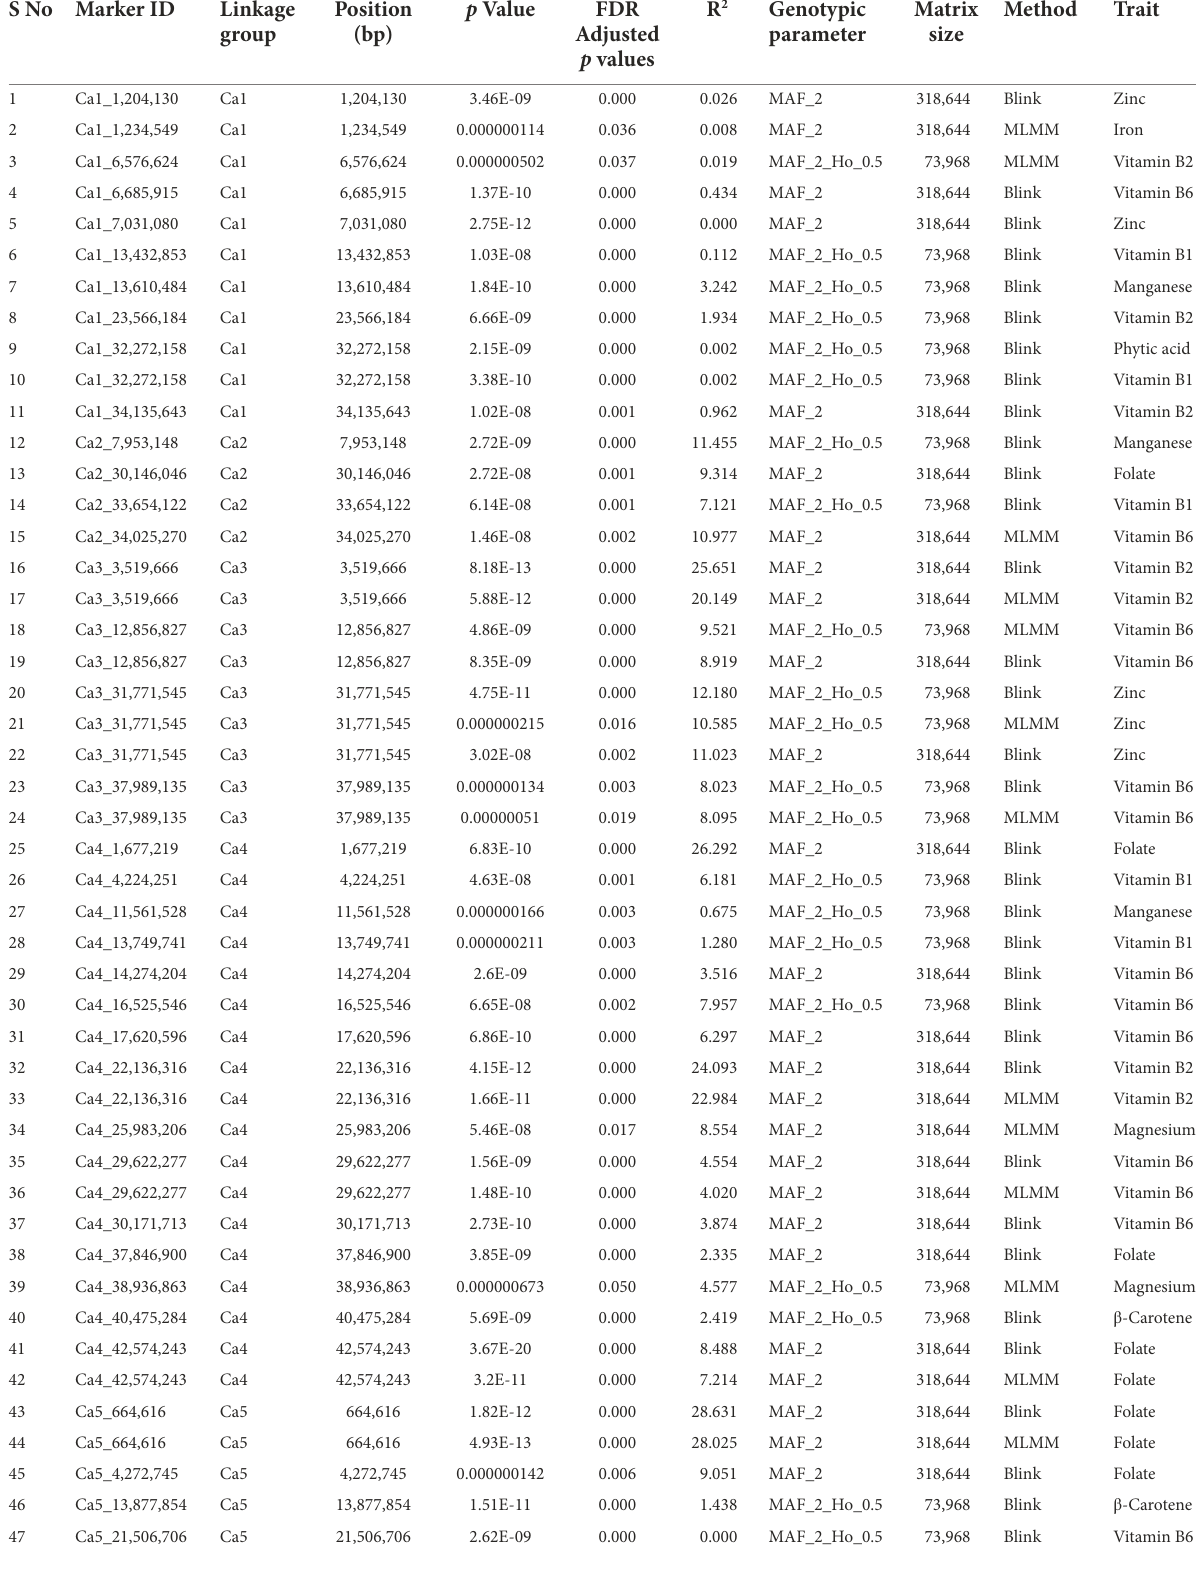
TABLE 2 The MTAs detected for 12 nutritional traits using two multi-locus algorithms and two genotypic matrices based on two levels of Ho ( ≤ default in data and 0.05) with MAF ≥